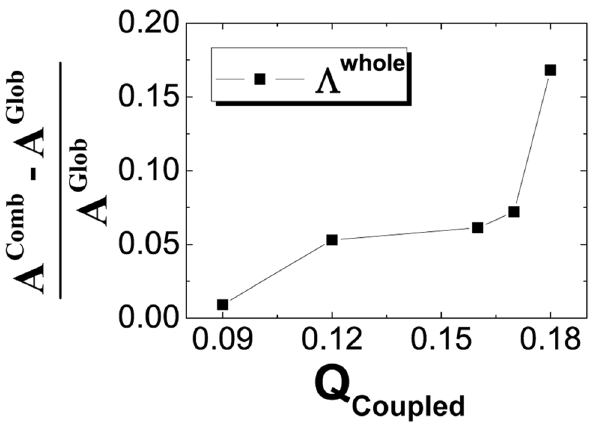
Figure 7. The evolution of the differences between the combined and whole global binding-folding energy land- scapes as a function of Q Coupled . The difference between the combined and whole global binding-folding energy landscapes